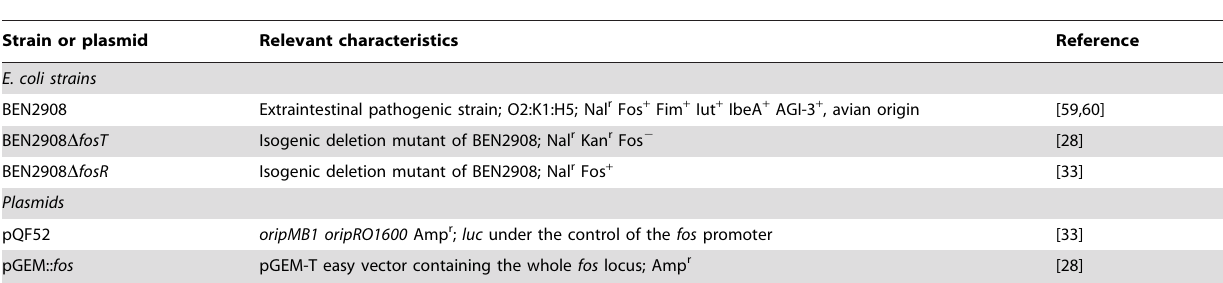
Table 1. Bacterial strains and plasmids used in this study.